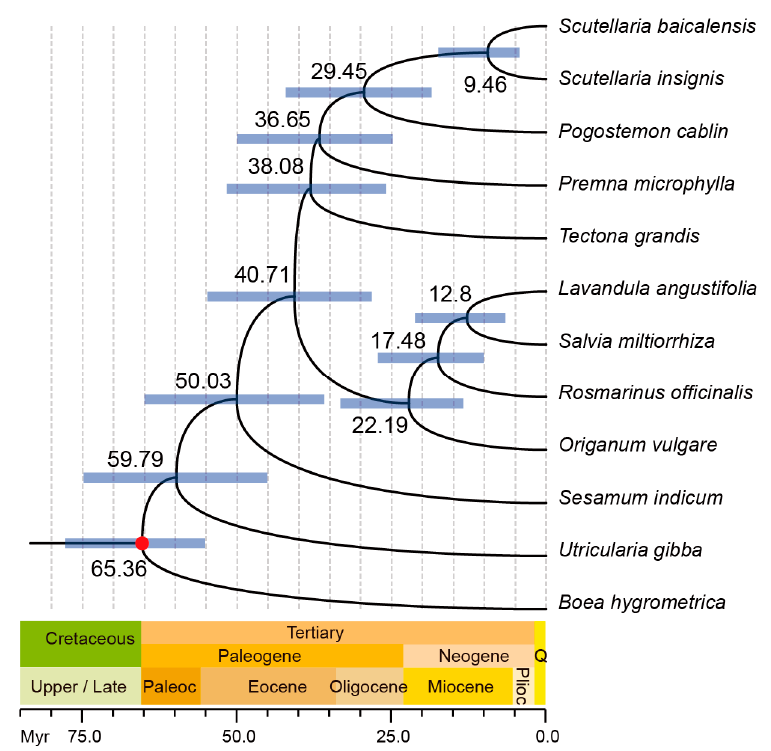
Figure 4. Phylogenetic tree reconstructed based on chloroplast genome alignments from several species. The purple bars at the nodes indicate 95% posterior probability intervals, while the red dot correspond to the calibration point.